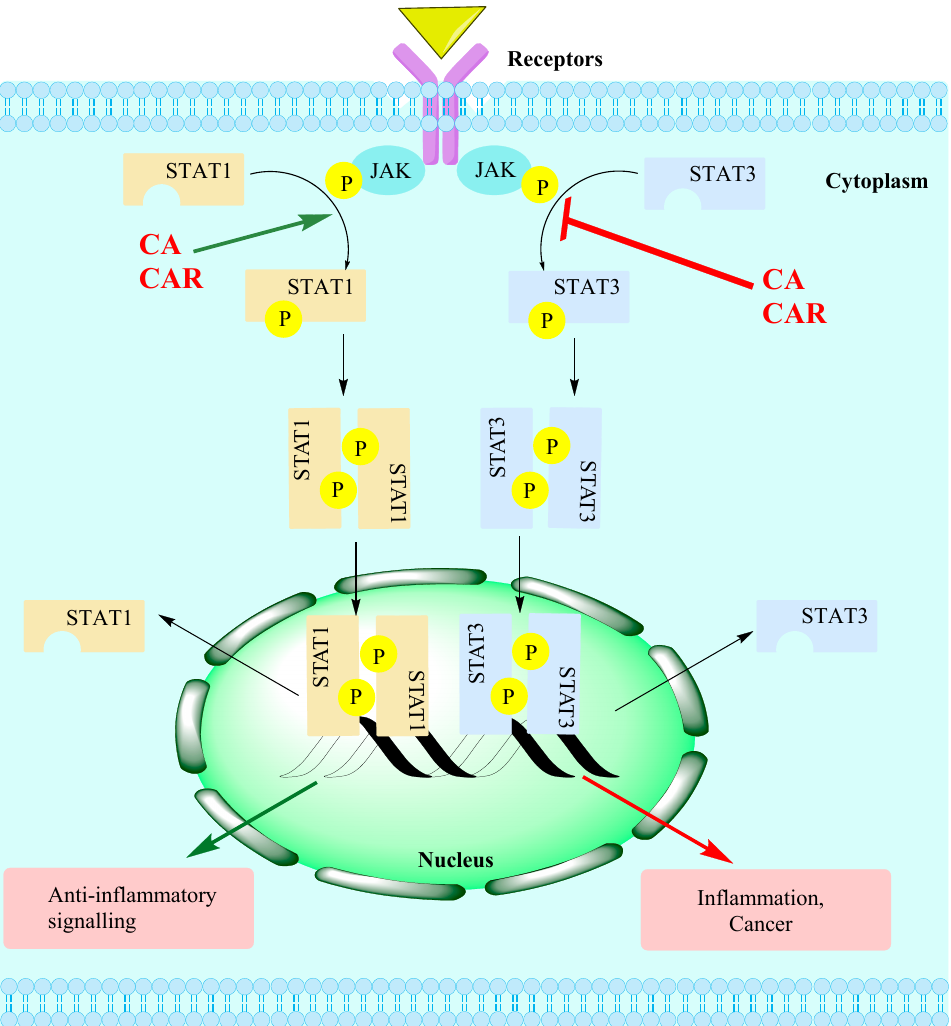
Figure 4. The JAK-STAT signalling pathway targets for CA/CAR. Several external stimuli such as UV radiation, infection, carcinogens, inflammatory mediators and stress can induce the activation of the STAT pathway. Activation of the JAK/STAT pathway associated with receptors’ activation (e.g., by cytokines) leads to the phosphorylation of JAKs. This, in turn, activates STAT monomers through phosphorylation of tyrosine residues, leading to STATs’ dimerisation. Translocation of activated STAT dimers to the nucleus and subsequent DNA binding activate target genes relevant to various physiological/pathological pathways including inflammation. The level of STAT1/3 activation has been shown to be suppressed by rosemary diterpenes, while SIRT1 has been shown to be activated.